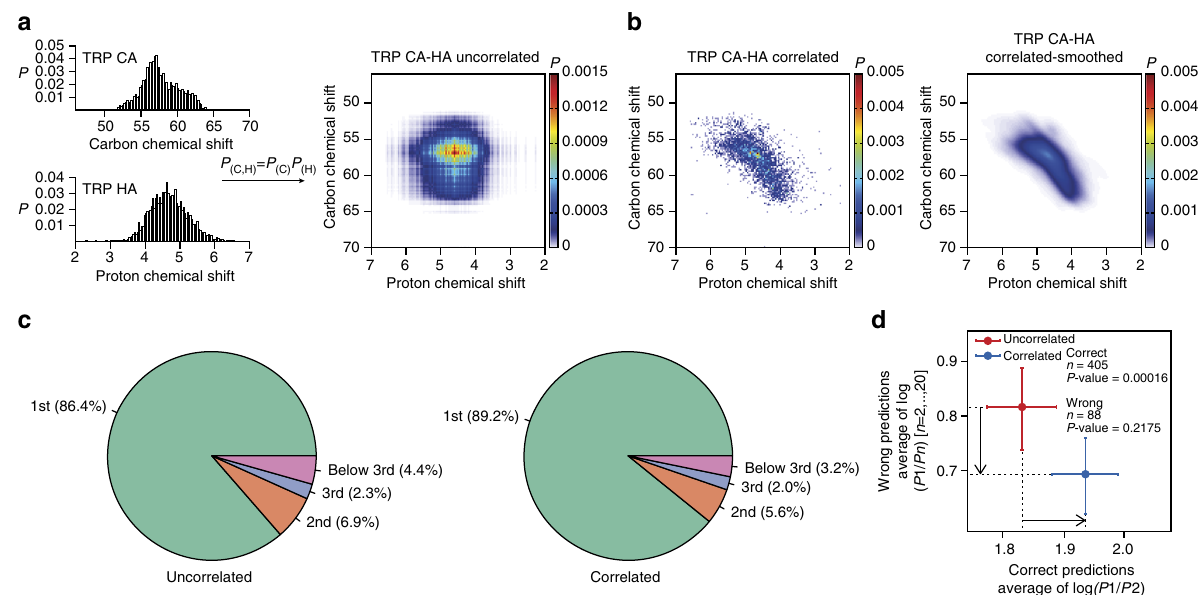
Fig. 1 Comparison of uncorrelated and correlated chemical shifts probabilities and their power in amino acid-type prediction. a The 1D probability distributions for the C α and H α atoms of Trp (left) and their joint probability distribution (right). b The 2D probability distribution of correlated C α – H α chemical shifts of Trp (left) and the corresponding smoothed 2D probability density map (right) after applying a Gaussian kernel function. Graphs were generated from the VASCO database with a bin size of 0.04 p.p.m. for protons and 0.2 p.p.m. for carbons. The color gradient scaling differs for ( a) uncorrelated and ( b) correlated distributions. c Pie charts displaying the ranking of amino acid-type predictions in the current dataset (four proteins) using uncorrelated (left) or correlated distributions (right) of 13 C – 1 H chemical shifts. d Analysis of common (correct or wrong) predictions made by using uncorrelated (red) or correlated distributions (blue) of 13 C – 1 H chemical shifts. Horizontal axis plots the mean value and standard error of correct predictions ( P 1) to the second probable ( P 2), and vertical axis plots the mean value and standard error of wrong predictions ( Pn ) to the fi rst probable ( P 1). Pairwise t -test shows that the improvement in predictions made by using correlated instead of uncorrelated 13 C – 1 H chemical shifts (arrows) is statistically signi fi cant for the correct ones ( P -value = 0.00016) but not for the wrong ones ( P -value = 0.2175). The discrepancy is attributed to the relatively small number of wrong predictions available for the test (405 vs